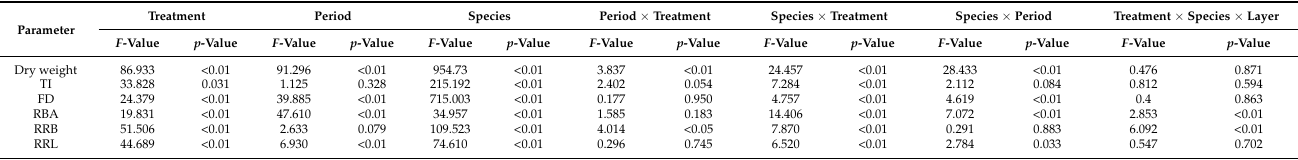
Table A1. Effects of species, periods, treatments, and their interactions on growth and response